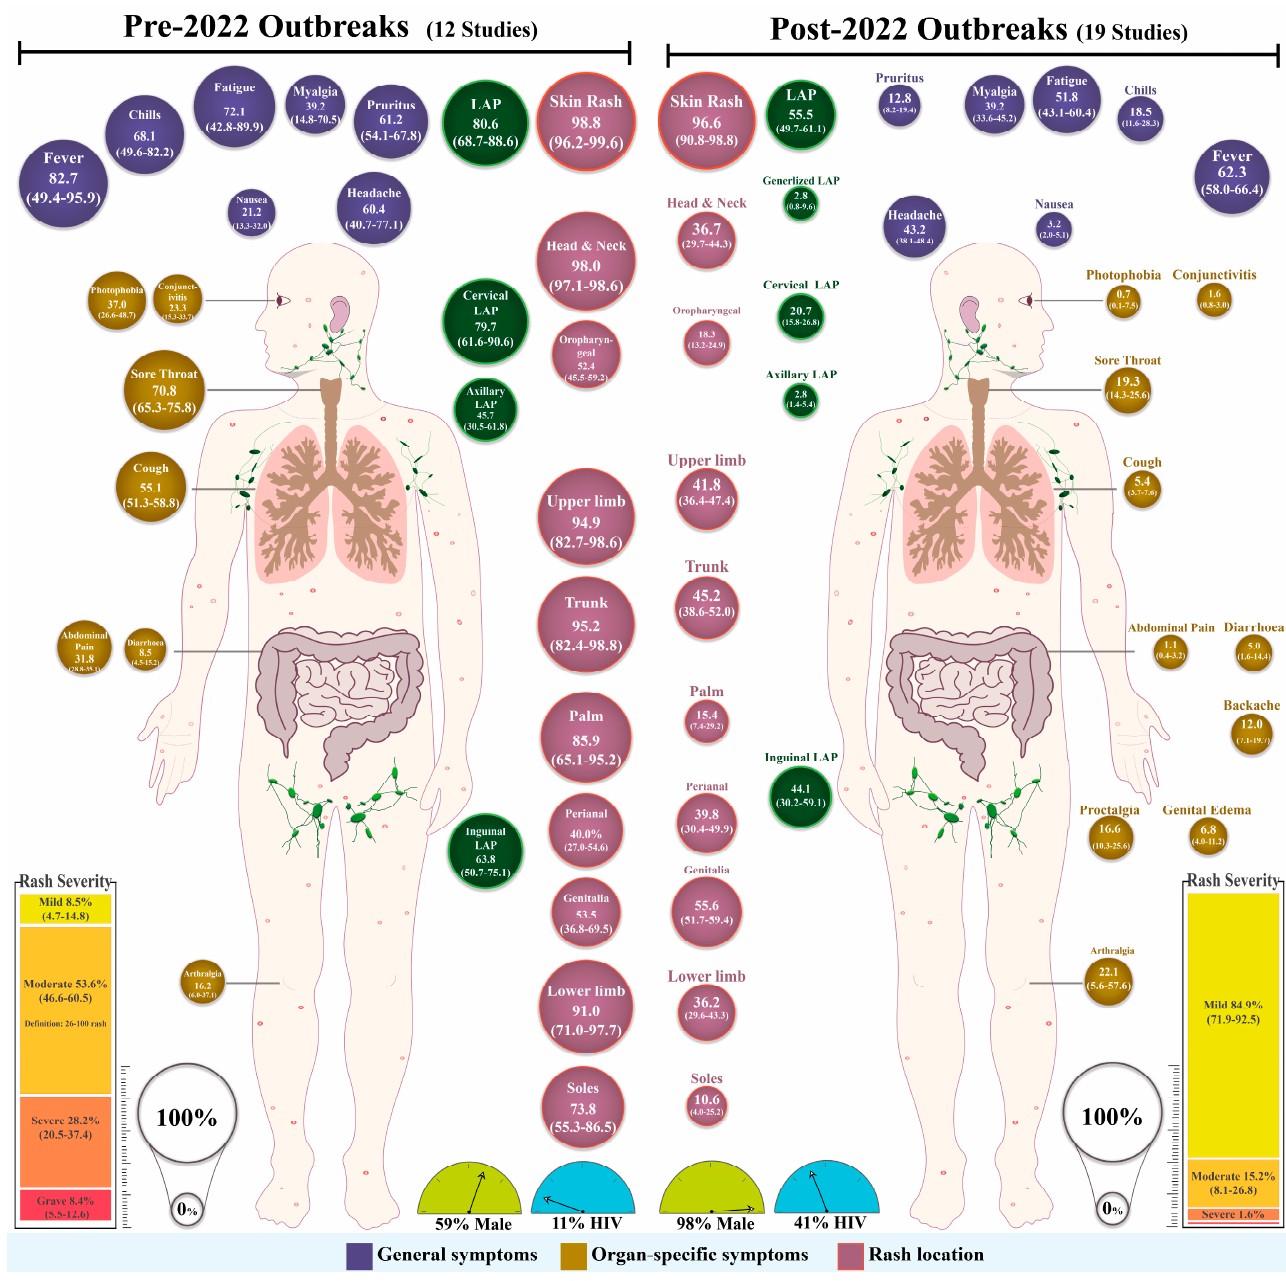
Figure 5. Clinical characteristics of mpox ‐ confirmed patients adjusted with the pooled frequency.